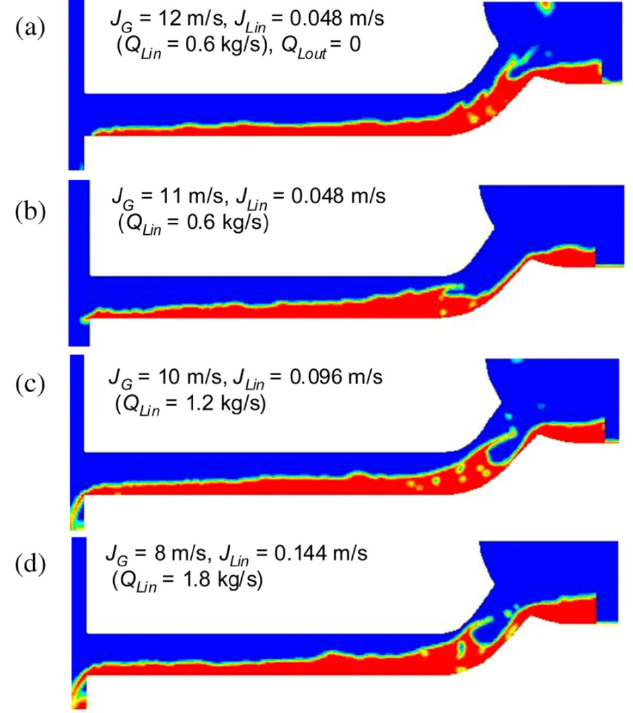
Figure 18. Flow patterns predicted by the VOF method (0.15 MPa); ( a – d ) flow patterns for different simulation cases (Kinoshita et al. [101]).